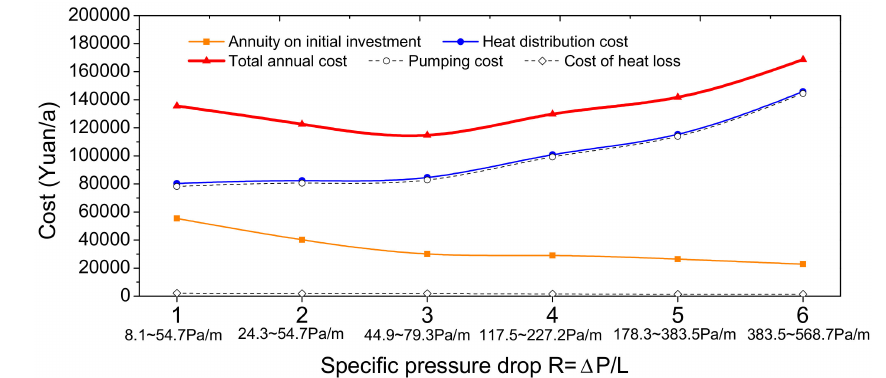
Figure 3. The annuity on the initial investment, heat distribution cost, and total annual cost at different R for the sample DH network with the intermediate pipe price and pump operating time.